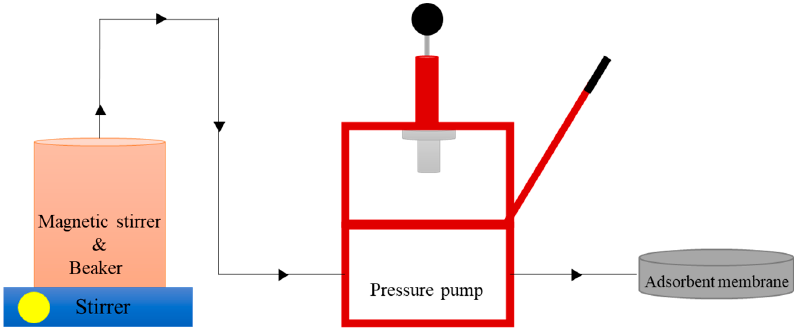
Figure 1. Schematic set-up fabrication of membrane adsorber PEFB.